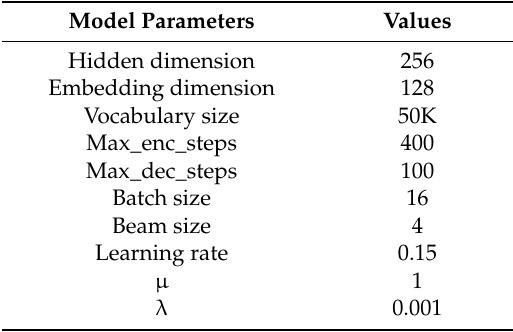
Table 1. Our model parameters at the training stage. Max_enc_steps and Max_dec_steps are the allowed maximum length of the source text input encoder and the generated summary,